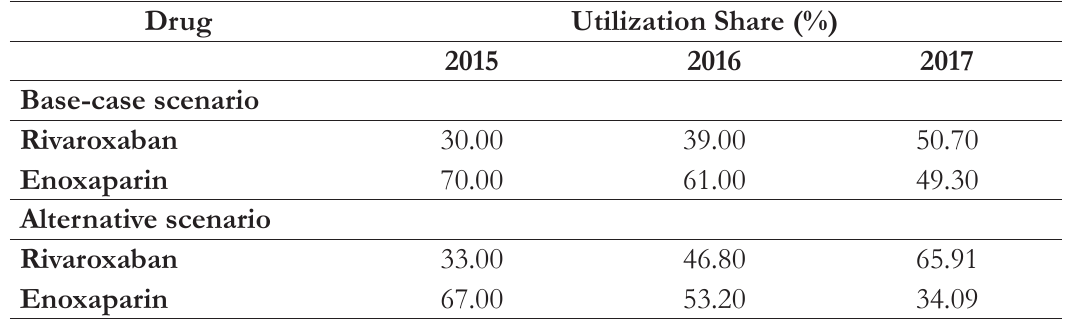
Table 3. Percentage of Use of Rivaroxaban and Enoxaparin over 3 Years for both Hip and Knee Replacement Cohorts in the Base-case and Alternative